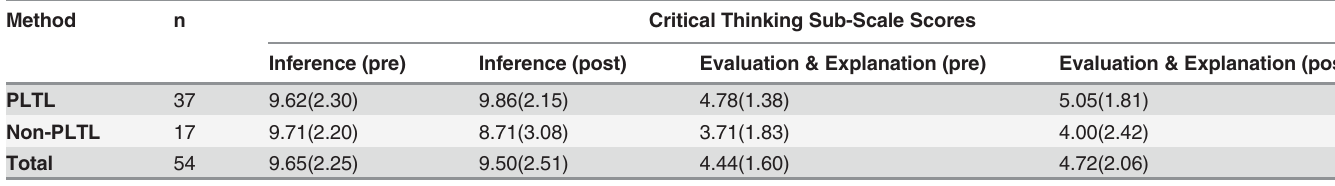
Table 6. In fl uence of Method on Critical Thinking Sub-Scale Scores (Inference, Evaluation & Explanation).